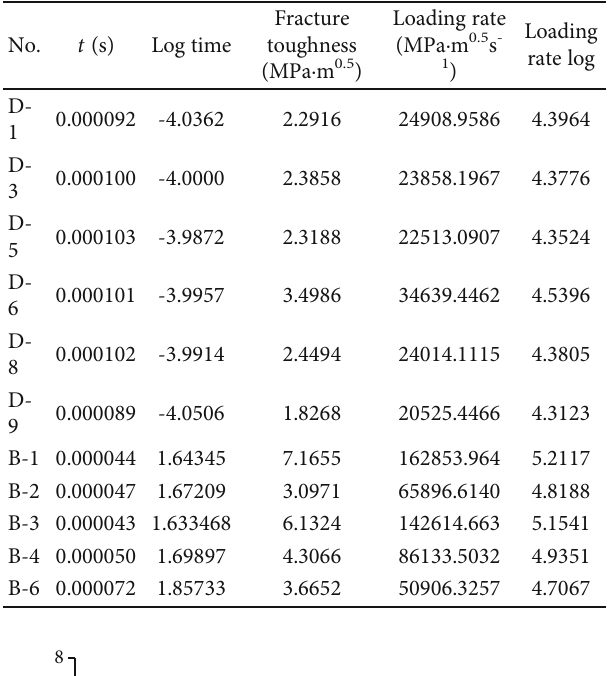
Table 2: The results of the rock dynamic fracture tests under dynamic loading.